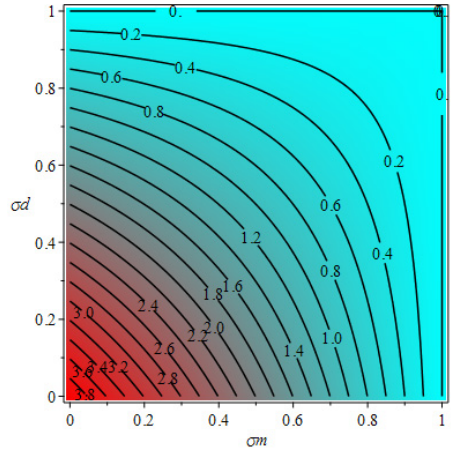
Figure 13. Contour plots of the reproduction number of the model (3), as a function of social distancing and mass media